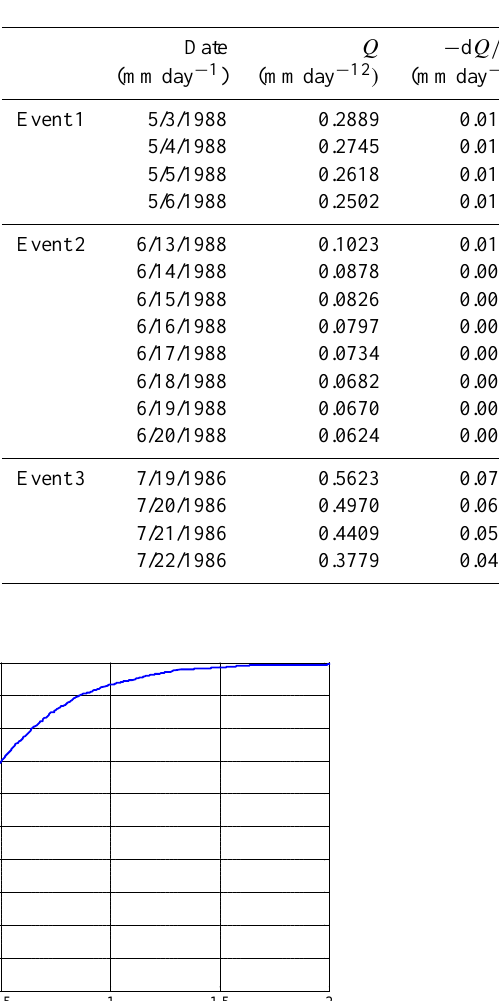
Table 3. Three individual recession events in the Spoon River watershed.